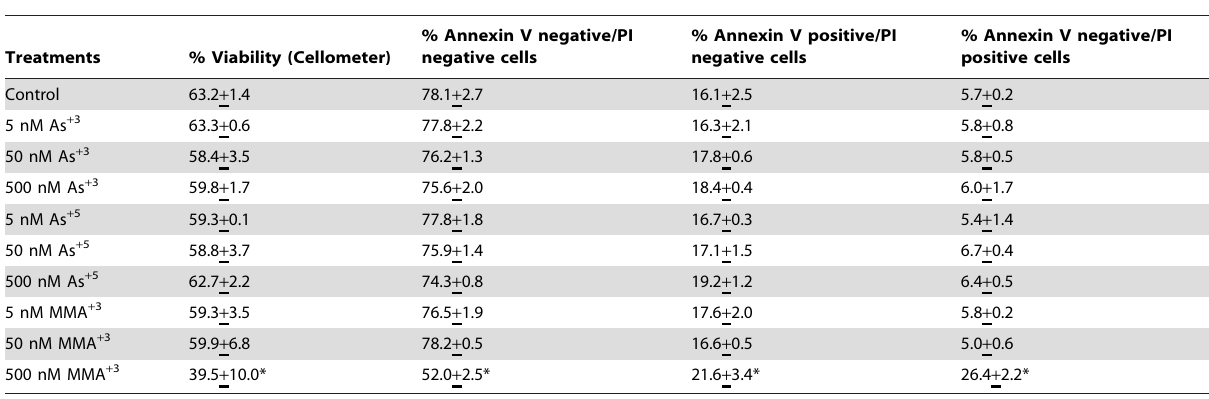
Table 2. In vitro (18 hrs) As + 3 , As + 5 or MMA + 3 Exposure and Effects on Mouse Bone marrow Cell Viability 1